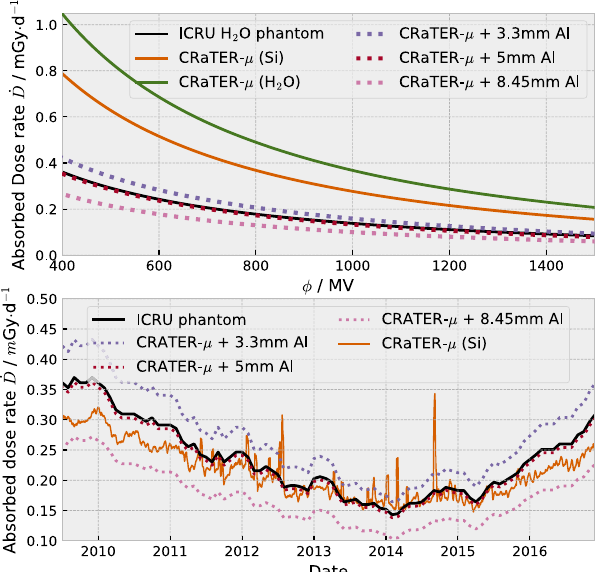
Fig. 10. Conversion factor between Si and H 2 O for the slab phantoms, as a function of the / parameter and atomic number Z . The dotted black line indicates the net conversion factor.